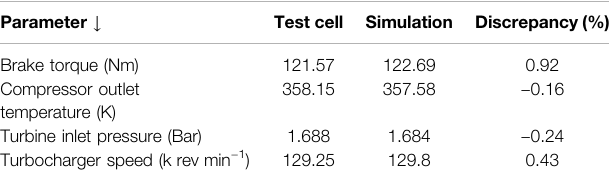
TABLE 4 | Comparison of engine performance parameters between test cell and simulation for the 8 Bar BMEP at 3,000 rev min − 1 cruise